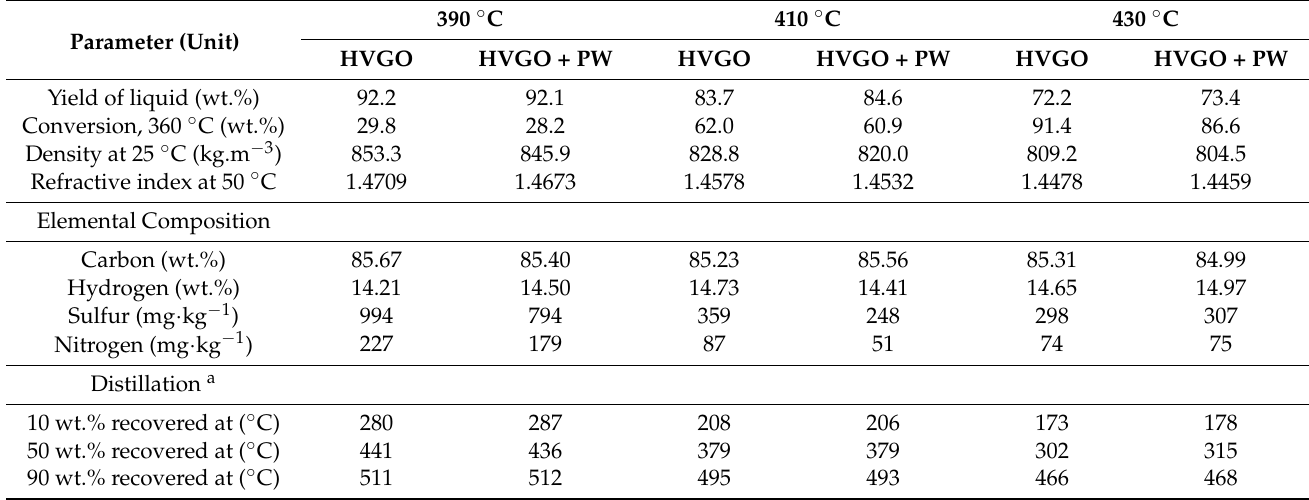
Table 2. Hydrocracking summary and basic properties of primary liquid